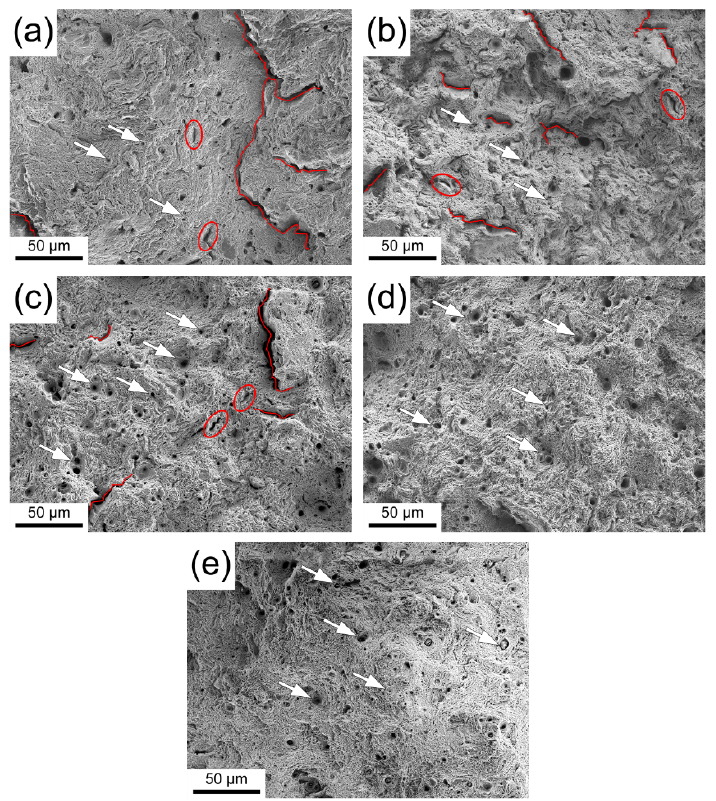
Figure 8. SEM micrographs of the tensile fracture surfaces of the T92 heat-resistant steel samples tempered at different temperatures: ( a ) 715 °C, ( b ) 740 °C, ( c ) 765 °C, ( d ) 790 °C, and ( e ) 815 °C.